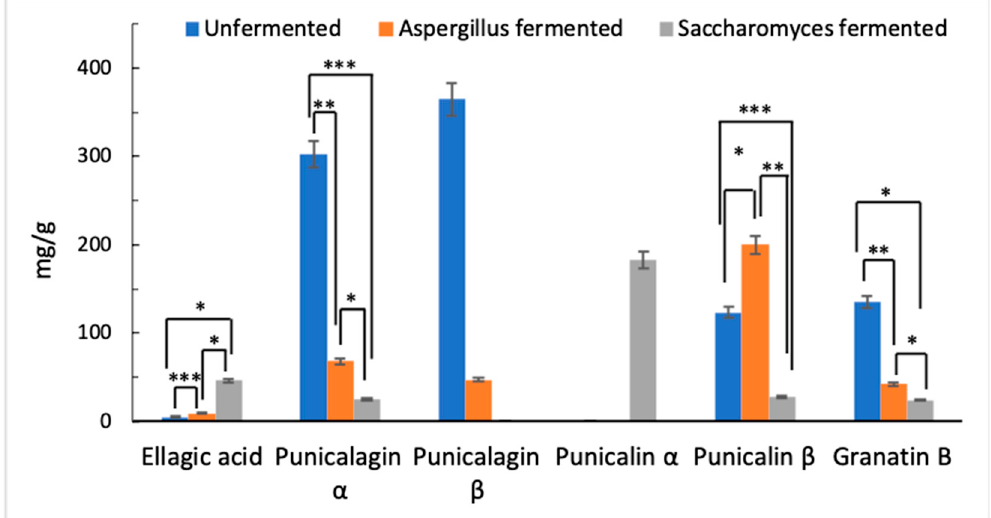
Figure 1. Quantitative analysis of the main ellagitannins identified in the fermented/unfermented pomegranate husks extracts. Statistical analysis is shown on the bars: * p < 0.05; ** p < 0.01; *** p < 0.005. It is known that hydrolytic cleavage of punicalagin α and β at the sugar moiety leads to punicalin α / β and hexahydroxydiphenic acid (HHDP), this latter then converted to EA by spontaneous lactonization (Scheme